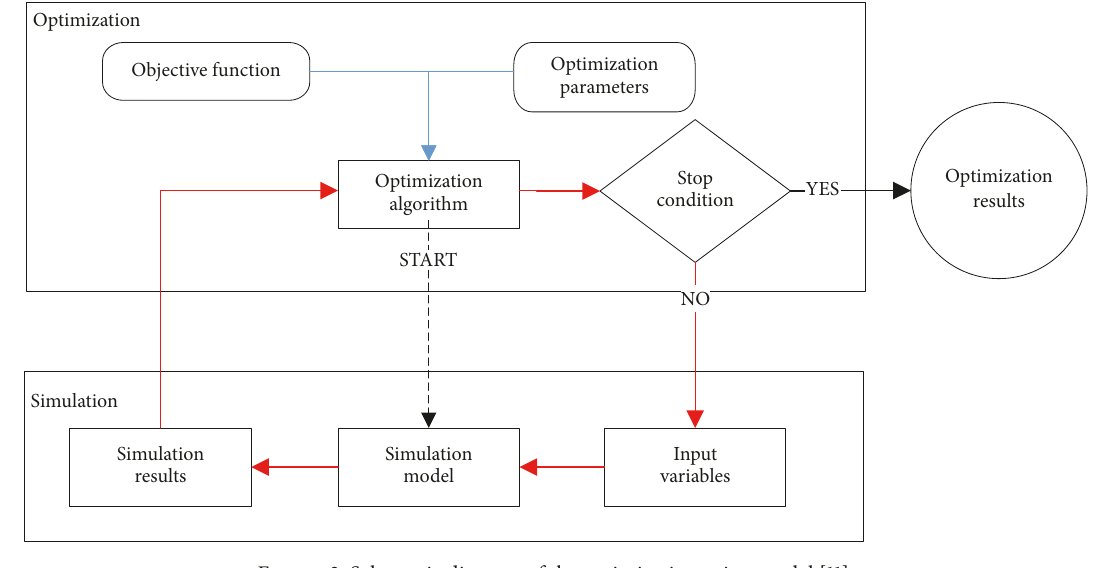
Figure 2: Schematic diagram of the optimization using model [11].